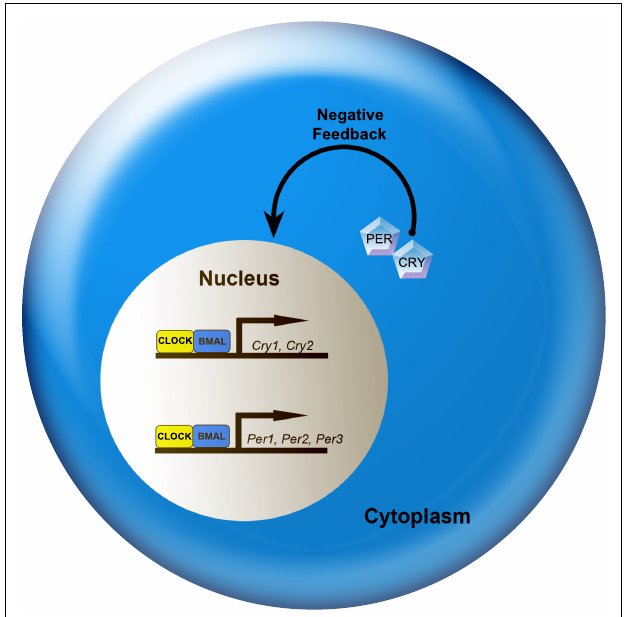
FIGURE 2 |A simplified model of the intracellular mechanisms responsible for mammalian circadian rhythm generation. The process begins when CLOCK and BMAL1 proteins dimerize to drive the transcription of the Per (Per1, Per2, and Per3) and Cry (Cry1 and Cry2) genes. In turn, Per and Cry are translocated to the cytoplasm and translated into their respective proteins.Throughout the day, PER and CRY proteins rise within the cell cytoplasm.When levels of PER and CRY reach a threshold, they form heterodimers, feed back to the cell nucleus and negatively regulate CLOCK:BMAL1 mediated transcription of their own genes.This feedback loop takes ∼ 24h, thereby leading to an intracellular circadian rhythm. See text for additional